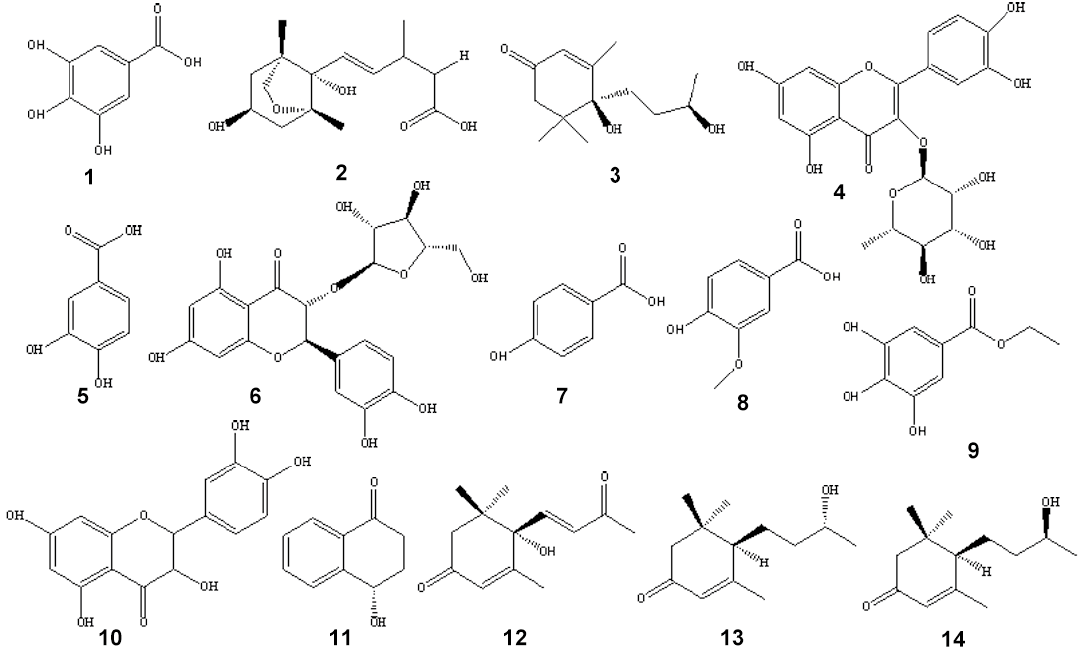
Figure 3. Chemical structures of compounds isolated from Diaphragma juglandis fructus.